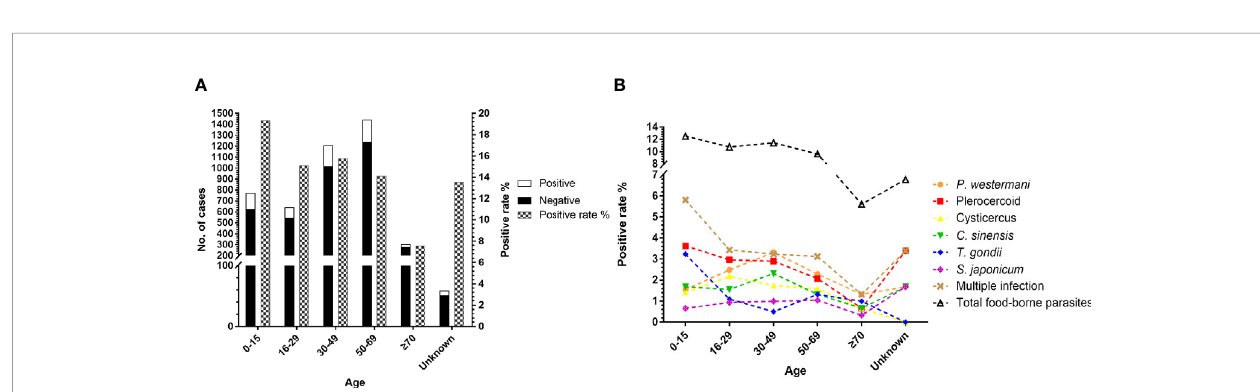
FIGURE 3 | Comparison of the prevalence of parasites in patients according to age. (A) Number of cases received and the prevalence of total parasitic infection among age groups. (B) Comparison of the prevalence of the six most commonly detected parasites among age